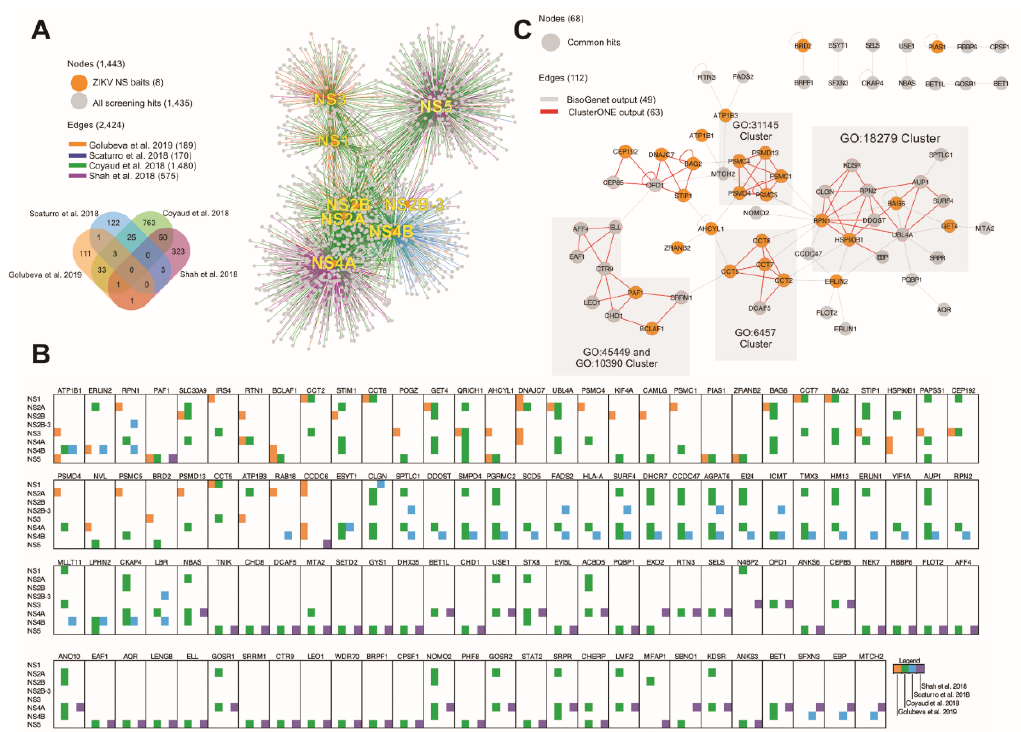
Figure 4. Integration of ZIKV PINs . ( A ) Network of the interactions identified by this study, Scaturro et al. 2018, Shah et al. 2018, and Coyaud et al. 2018. The color legend is depicted on the upper left-hand corner. ( B ) Graphic representation of common preys according to the bait and study in which they were identified. ( C ) Clustering of bait sets according to overlapping protein complexes among the integrated network using ClusterONE (Version 1.0) [29]. Gene ontologies of these networks were obtained by the Cytoscape plugin, BINGO [30]. GO accession numbers represent the following biological process: GO31145—anaphase promoting complex (APC)-dependent proteasomal ubiquitin-dependent protein catabolic process, GO18279—protein amino acid N-linked glycosylation via asparagine, GO6457—protein folding, GO45449—regulation of transcription, and GO33523—histone H2B ubiquitination. Proteins identified in this study are represented as orange nodes.